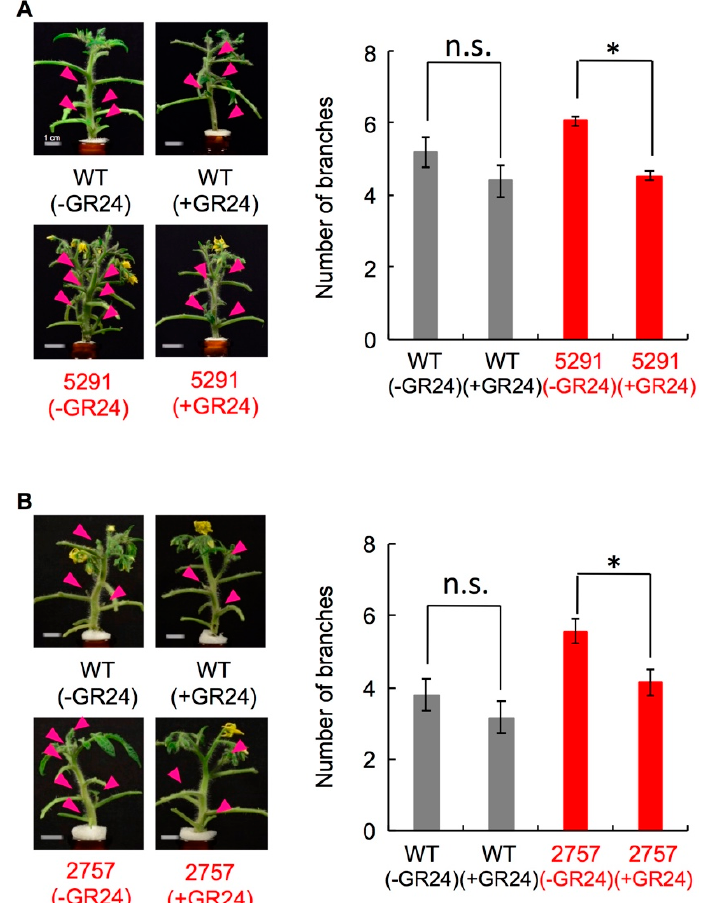
Figure 4. Effect of exogenously applied strigolactone (SL) on branching. GR24 (1 µM) was applied to 40-day-old seedlings of WT and ( A ) line 5291 ( n = 3) or ( B ) line 2757 ( n = 4). Arrowheads show outgrowing axillary buds (>2 mm). Error bars, S.E. Student’s t -test, * p < 0.05, Asterisks indicate significant differences between untreated and treated slccd8 mutants (Student’s t -test, * p < 0.05; n.s., not significant).